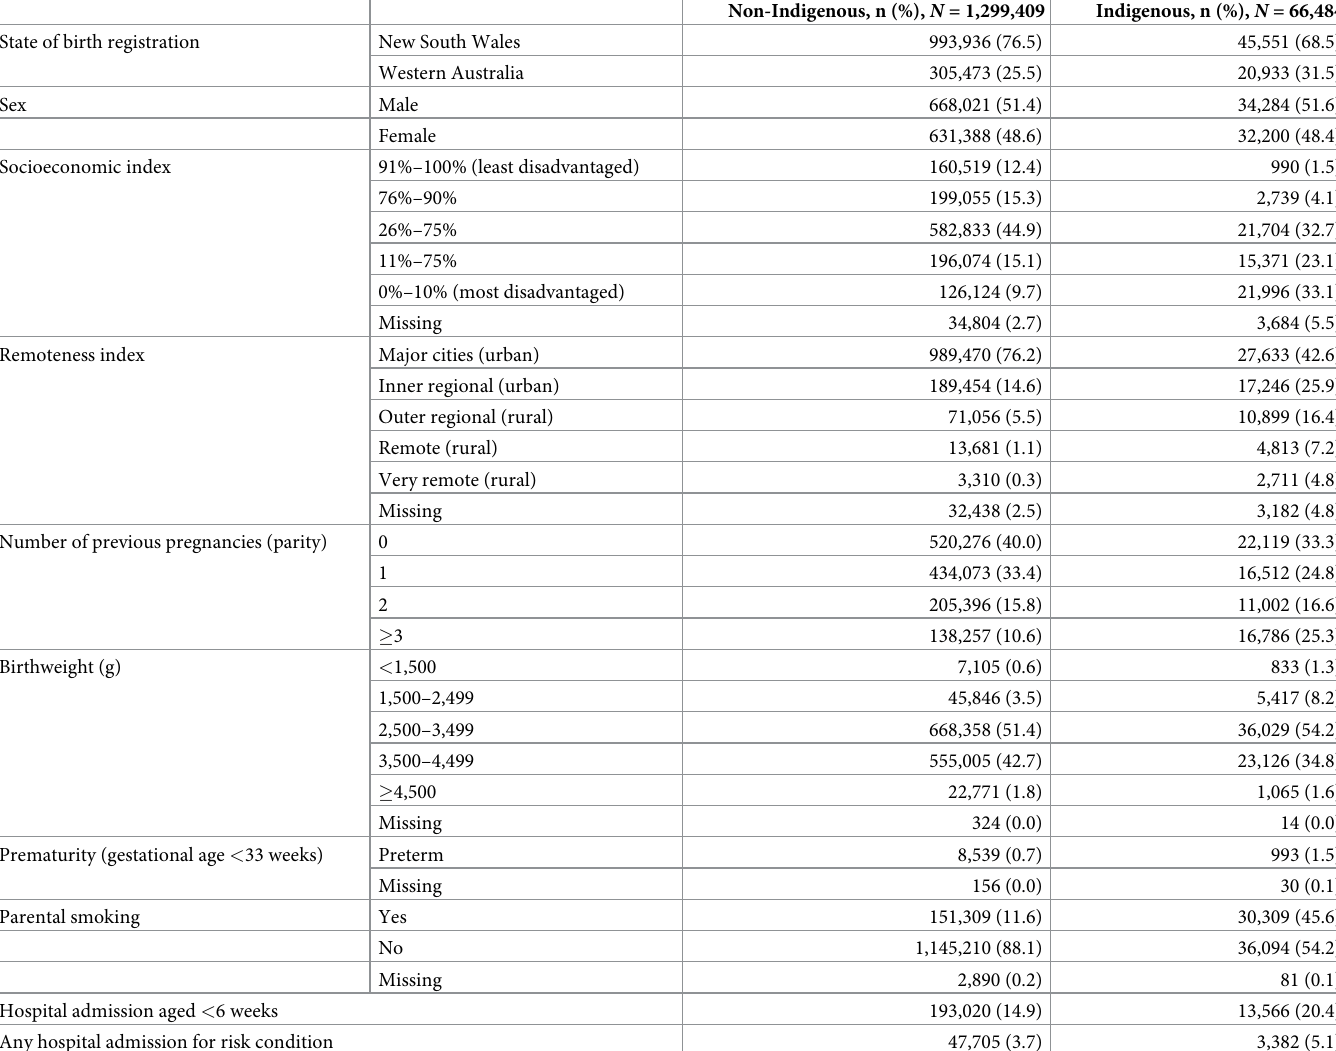
Table 1. Cohort characteristics by Indigenous status, New South Wales and Western Australia,